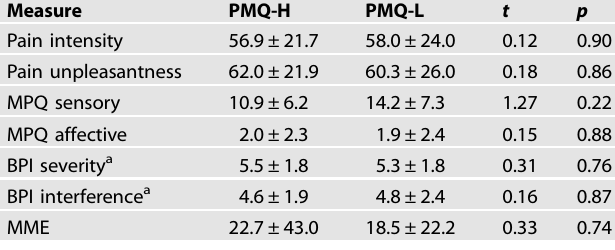
Table 1. Chronic back pain